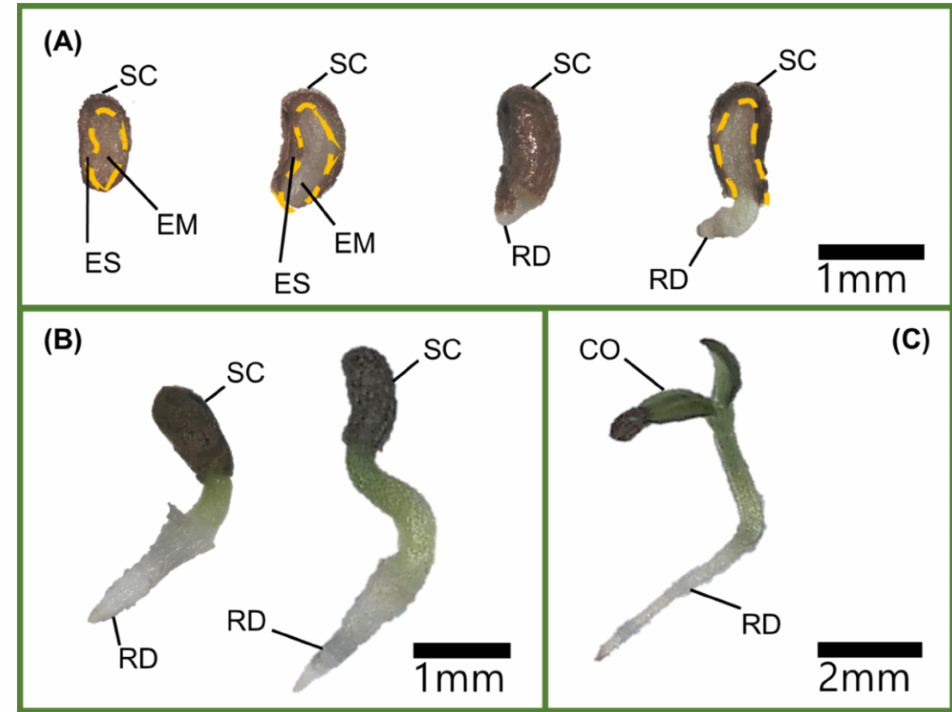
Figure 8. Germination and radicle emergence in seeds of V. sibiricum . ( A ) Seed cross section and germination (the top right seed) at early stages, ( B ) radicle emergence, and ( C ) shoot emergence. Scale bar is 1 mm. (SC = seed coat, EM = embryo, ES = endosperm, RD = radicle, and CO = cotyledon). The yellow line represents the boundary between the embryo and the